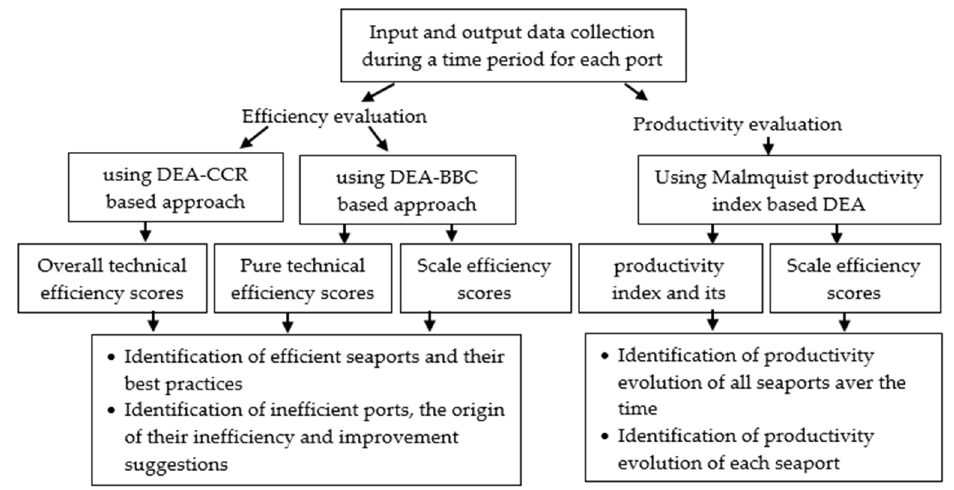
Figure 1. Flowchart of the proposed approach.